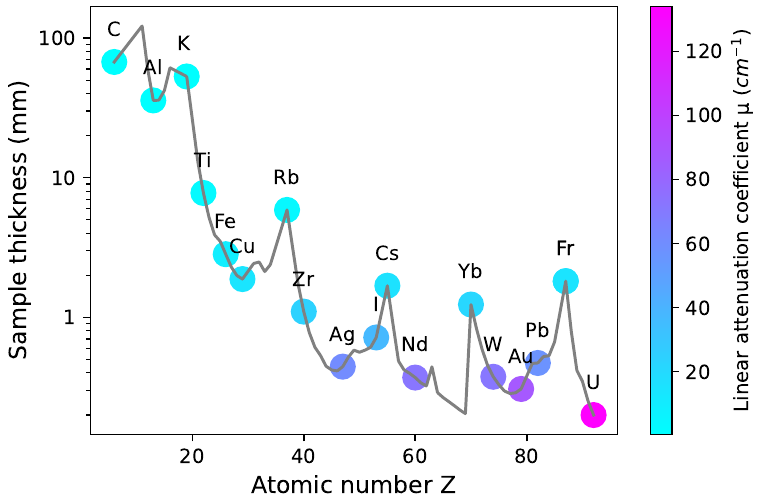
Figure 8. Estimation of sample thickness for a loose particle sample in a capillary for a material with atomic number Z. Calculations assume a packing density of 60%, an X-ray transmission of 20% and an effective energy of 60 keV [101], for which mass attenuation coefficients µ / ρ have been taken from in the National Institute of Standards and Technology’s (NIST, USA) X-ray Mass Attenuation Coefficients database [102]. The grey line shows estimated sample thickness for all elements (Z = 8 to Z = 92, excluding gases), while the coloured dots highlight selected elements. The colour represents the linear attenuation coefficient, µ , calculated from the mass attenuation coefficient µ / ρ and the density ρ